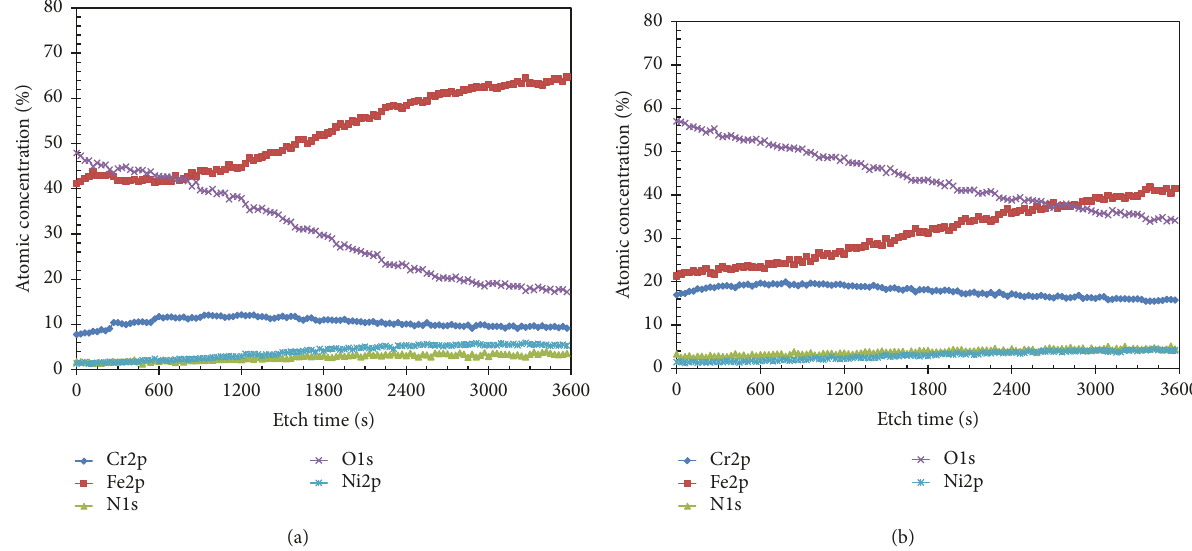
Figure 6: Depth profiles for the nitrided layers of (a) N and (b) NK samples.